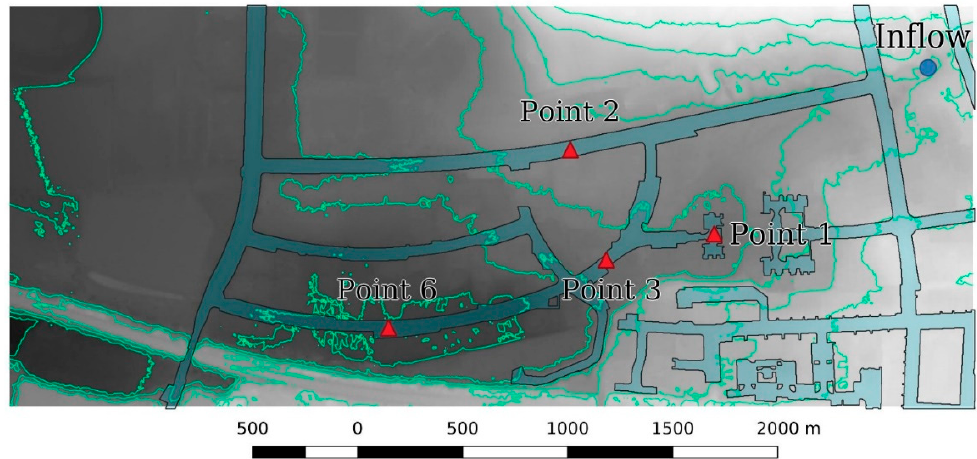
Figure 13. Setup of Test 8A. White areas represent higher elevations. Measurement points are marked in red. A point inflow is marked in blue. Streets are painted in a bluish tone and use a different Manning coefficient than the rest of the domain.